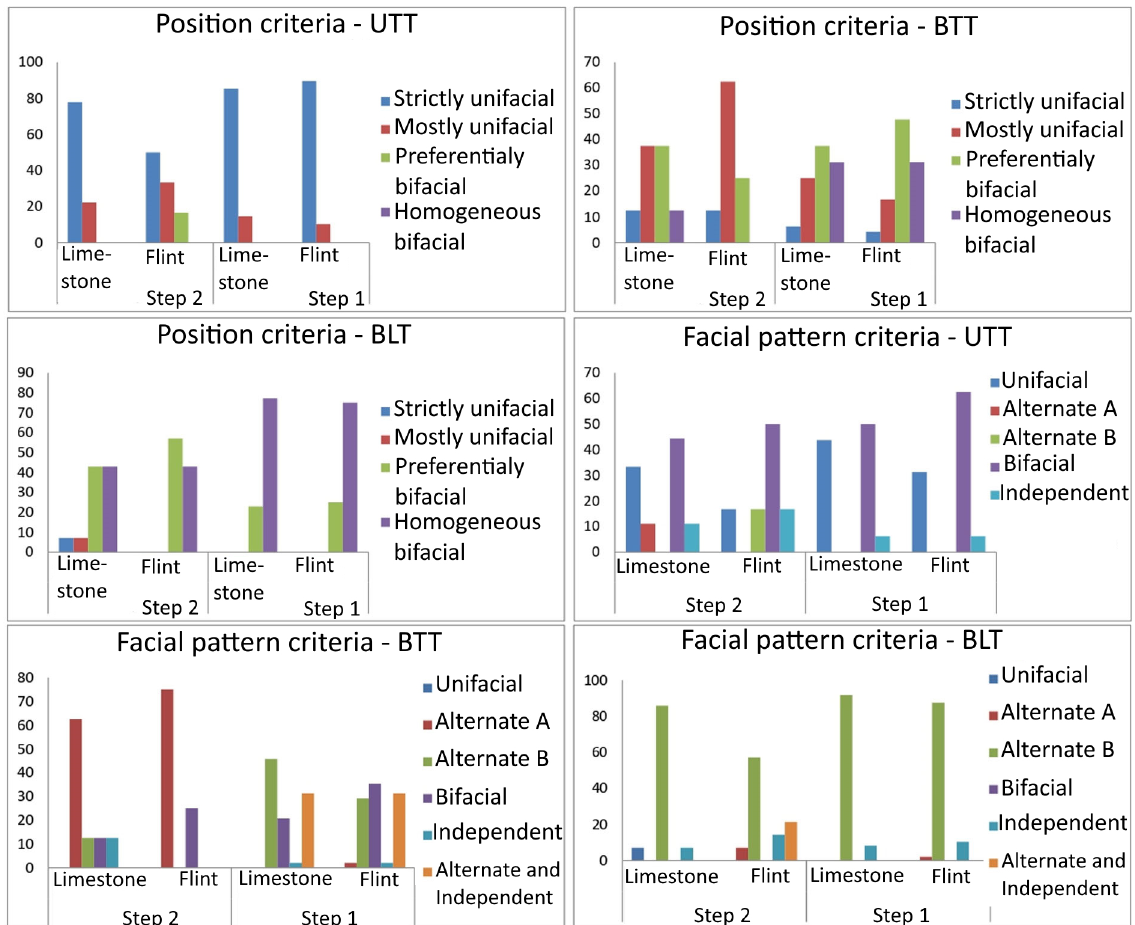
Figure 11. Comparison to experimental step 1 and 2, for the position and the repartition